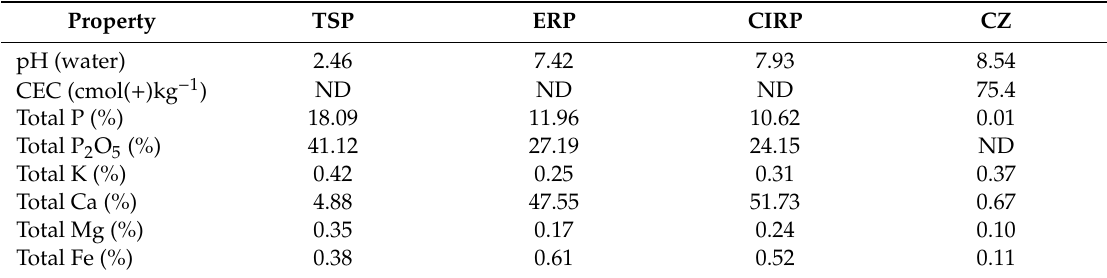
Table 3. Selected phosphorus fertilizers and Clinoptilolite zeolite chemical properties.